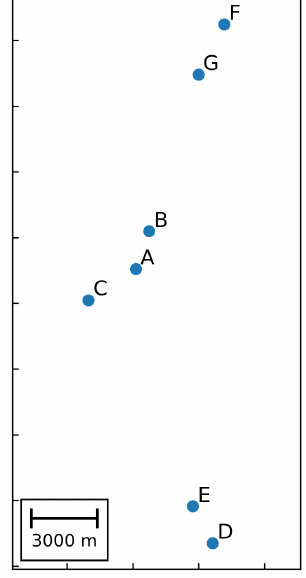
Figure 2. Relative positions of experimental wells.